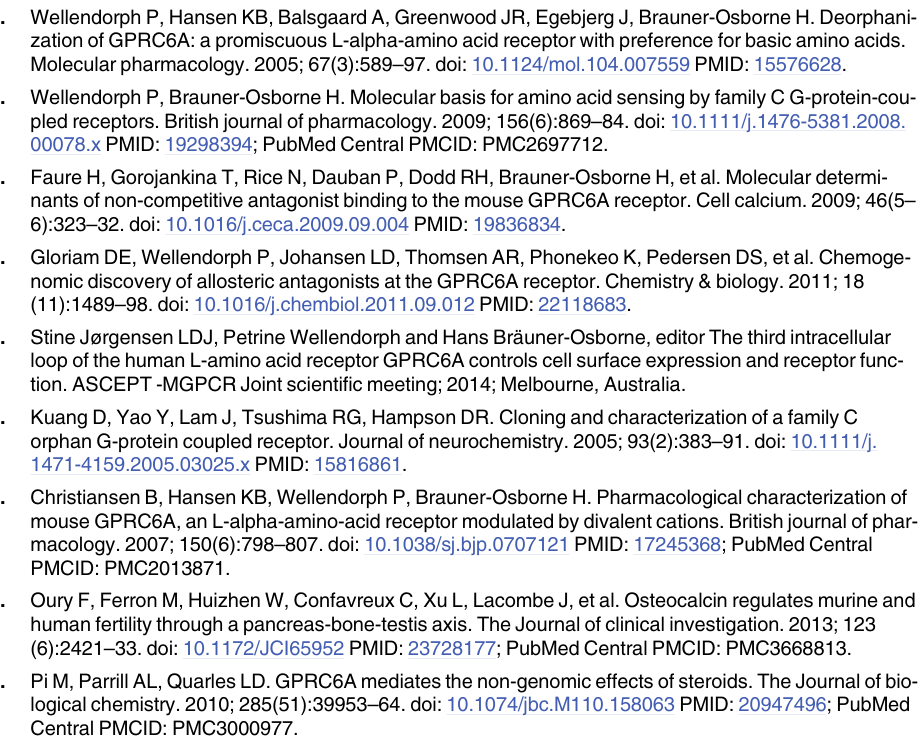
S3 Fig. Insulin secretion by β -TC6 cells or mouse pancreatic islets. (A) Glucose significantly enhanced insulin secretion by β -TC6 cells ( P < 0.0001, two-way ANOVA), but there was no significant effect of either L-ornithine (20 mM) or human synthetic OCN (acid form; 0.03 – 100 ng/ml) to increase GSIS. (B) High [glucose] significantly enhanced insulin secretion by mouse pancreatic islets ( P < 0.0001, two-way ANOVA). L-arginine (20 mM), but not human syn- thetic OCN (0.03 – 100 ng/ml) significantly increased GSIS ( (cid:1) P < 0.05 vs. Vehicle, two-way ANOVA followed by Sidak ’ s multiple comparisons test). Open bars, no glucose; filled bars, 16.7mM glucose. S1 Table. Summary of functional assays performed in cell lines recombinantly or endoge- nously expressing